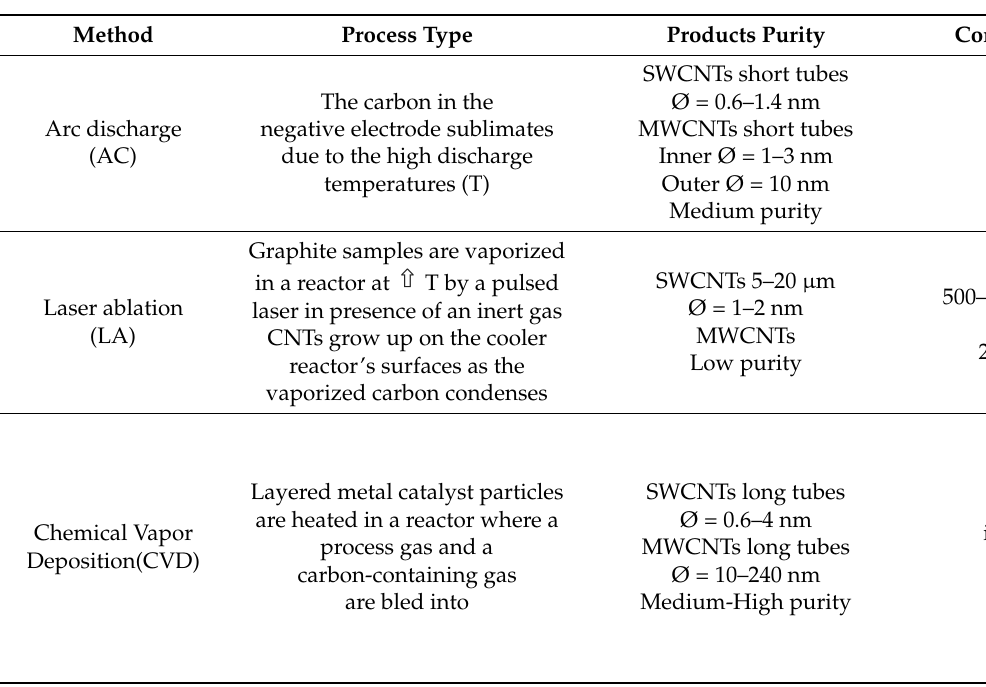
Table 5. The three most applied methods to synthetize CNTs.